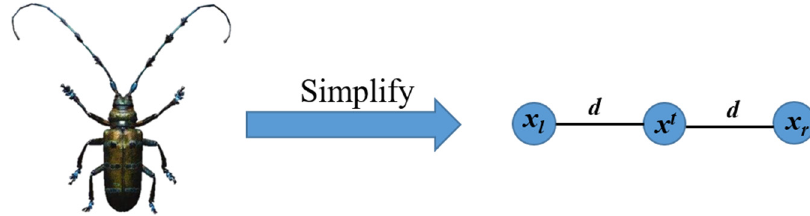
Figure 12. The foraging behavior of the beetle [104].